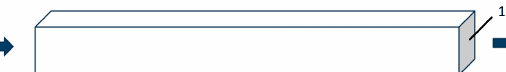
Figure 14. Outline of the large-scale model.